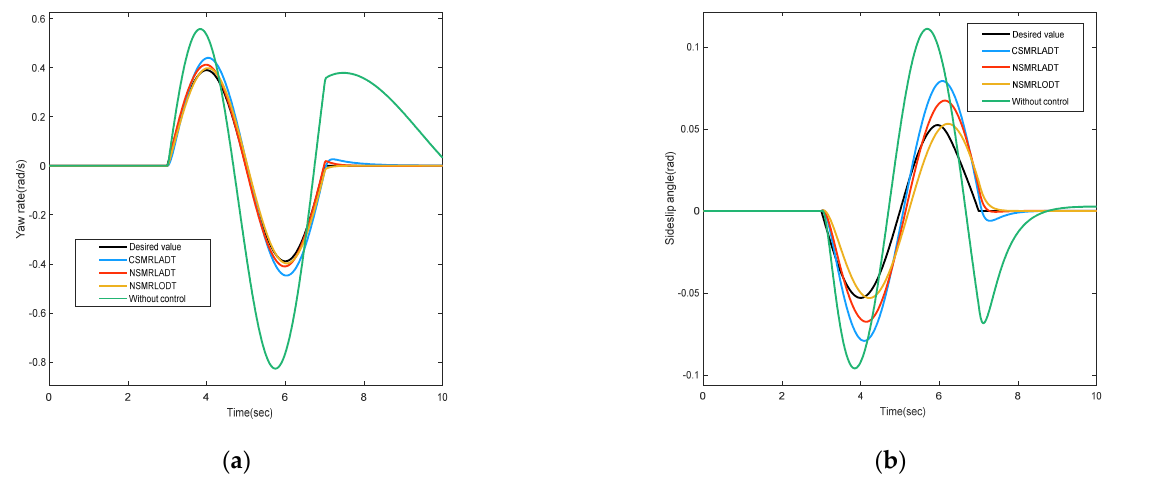
Figure 6. The curves of yaw rate and sideslip angle under SLC maneuver. ( a ) Yaw rate; ( b ) sideslip angle.